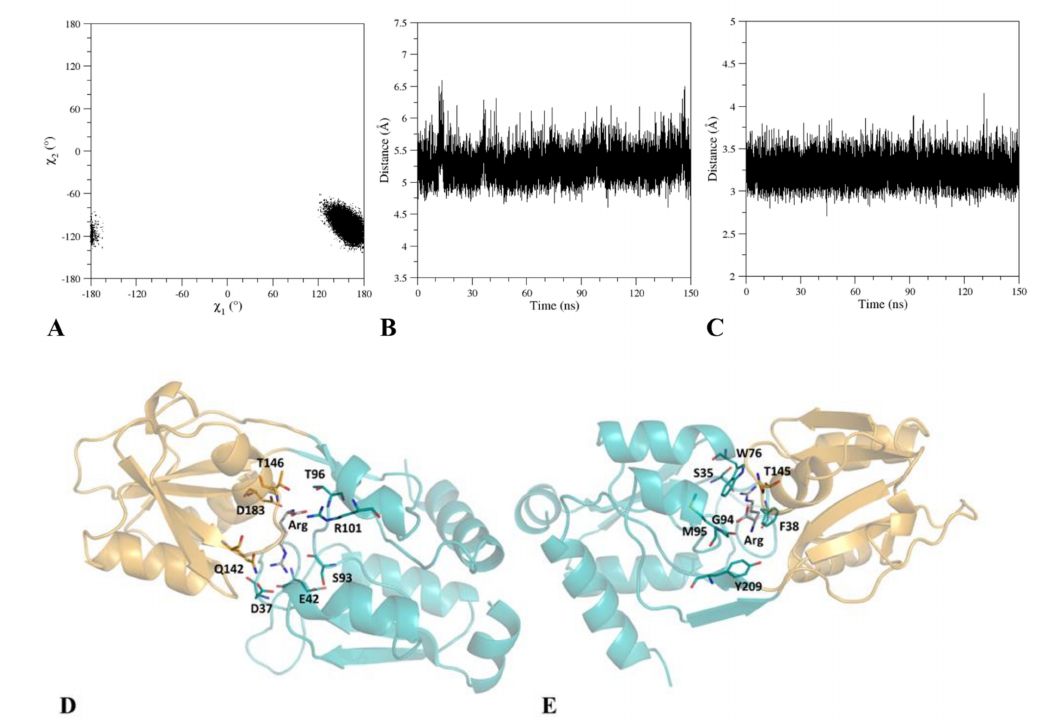
Figure 2. Rotameric states ( χ 1 and χ 2 dihedral angles) assumed by Trp76 in the molecular dynamics (MD) simulation of TmArgBP 20 − 233_F76W ( A ). Time evolution of the distances between: ( B ) the centers of mass and ( C ) the closest atoms of the arginine ligand and Trp76 residue. Cartoon representation of the arginine environment: residues involved in H-bonding ( D ) or hydrophobic ( E ) interactions with the ligand are shown as sticks. The MD structure ( t = 77.66 ns) closest to the average structure computed in the equilibrated region of the trajectory (20–150 ns) has been